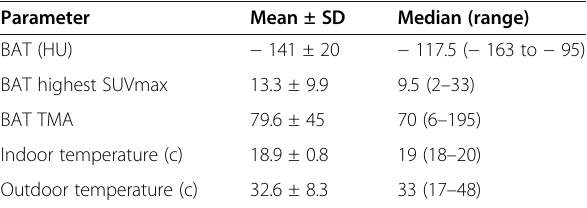
Table 3 SUVmax and TMA of activated BAT according to patients and tumor